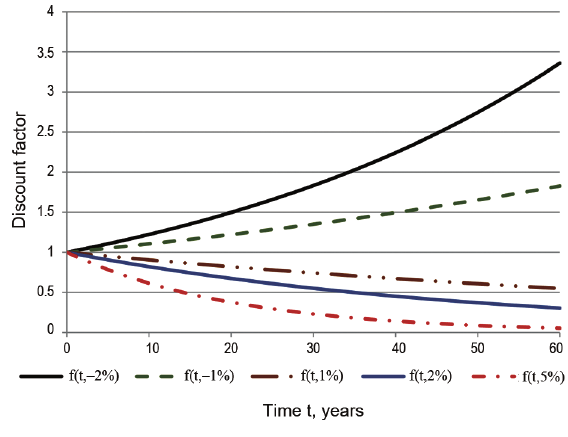
Fig. 6. Discount factor as a function of time and discount